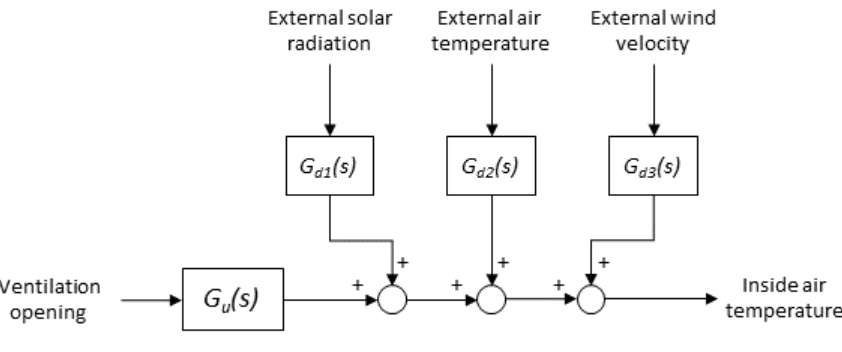
Figure 9. Transfer function models for input-output and disturbance-output